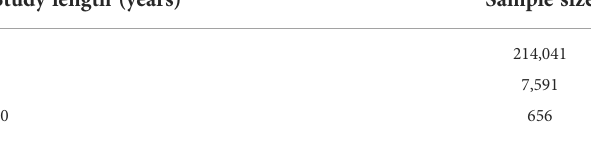
TABLE 3 Estimated sample size required for a clinical study designed to support or refute the results of the Markov modeling. Study length (years)